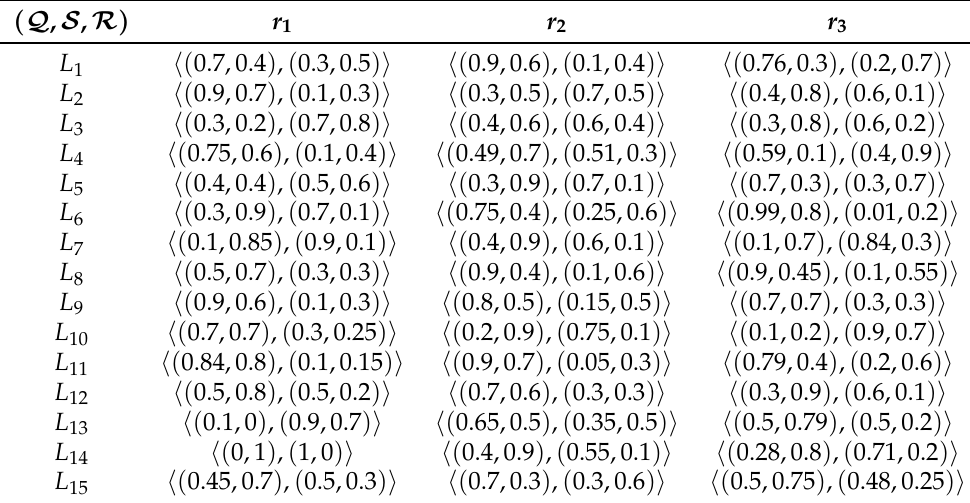
Table 15. Table for the 4-ROFBSS ( Q , S , R )